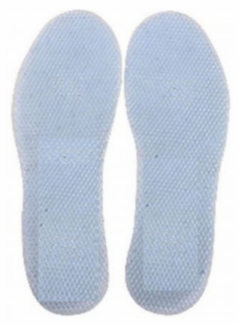
Figure 1. The textured insoles used in this